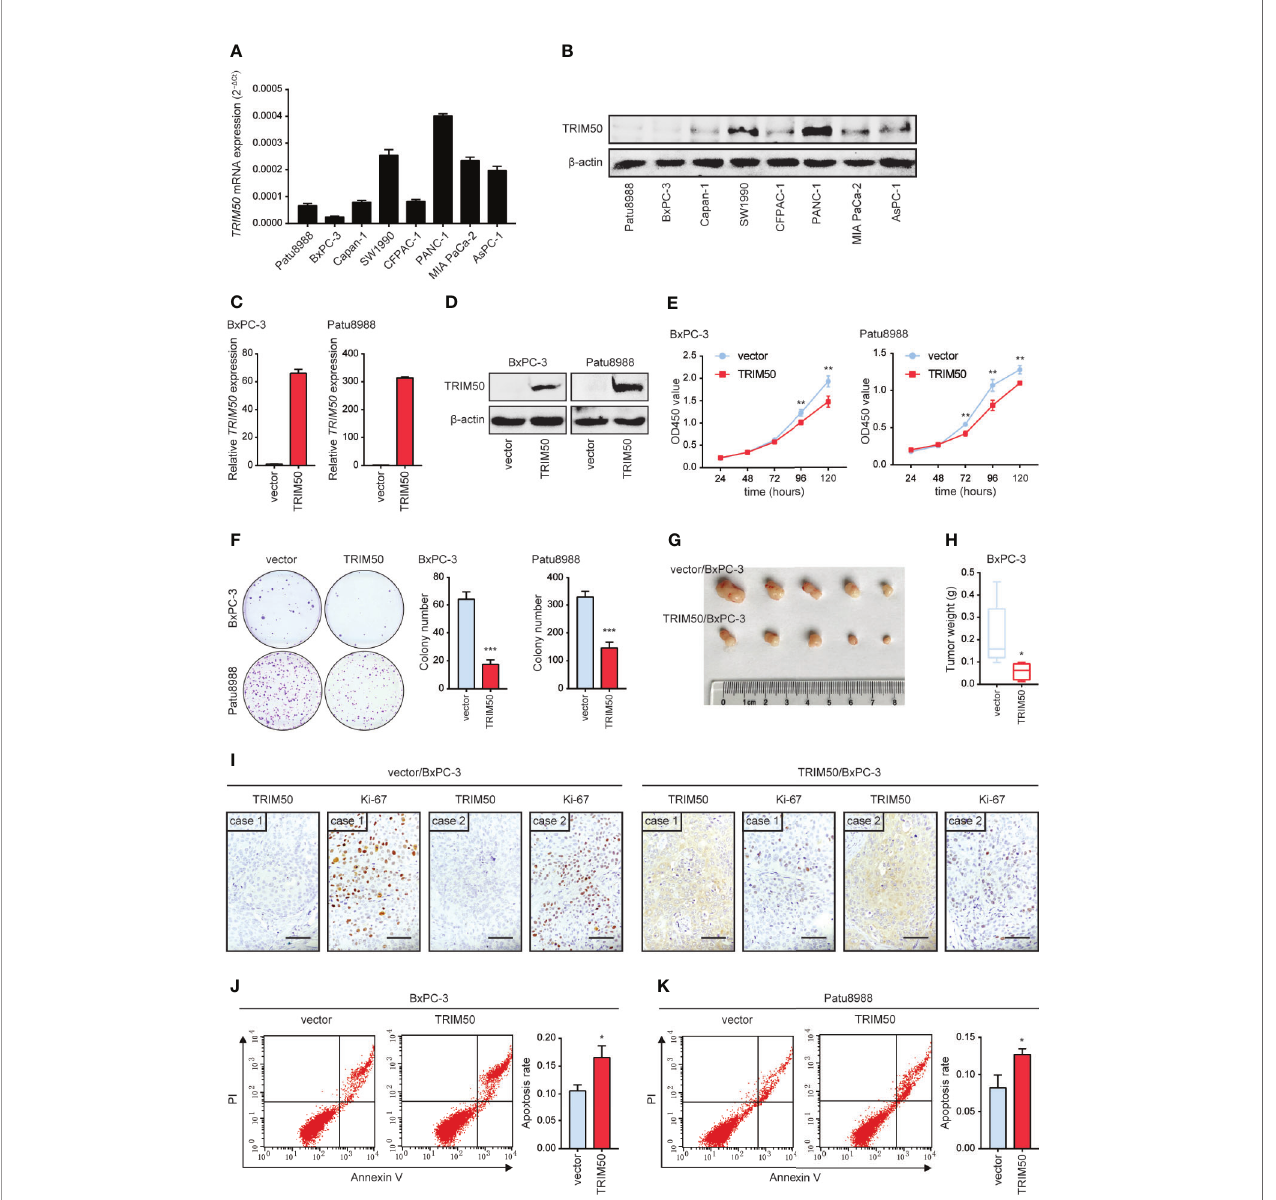
FIGURE 2 | TRIM50 overexpression suppresses tumor growth and induces cell apoptosis in pancreatic cancer. (A, B) Pancreatic cancer cell lines were assayed for relative TRIM50 expression by qRT-PCR (A) and western blotting (B). (C, D) The ef fi ciency of TRIM50 overexpression con fi rmed by qRT-PCR (C) and western blotting (D) . (E, F) The effect of TRIM50 overexpression on cell proliferation revealed by CCK-8 (E) and colony formation (F) assays. (G) Nude mice (5 per group) were subcutaneously injected with TRIM50-overexpressing and vector control cells; gross xenografts were shown 35 days after injection. (H) Weights of primary subcutaneous tumors were determined in (G) . (I) IHC staining of TRIM50 and Ki-67 in TRIM50-overexpressing and vector control subcutaneous xenografts. Scale bar: 50 m m. (J, K) The effect of TRIM50 overexpression on cell apoptosis of BxPC-3 (J) and Patu8988 (K) cells revealed by Annexin V/PI-labeled fl ow